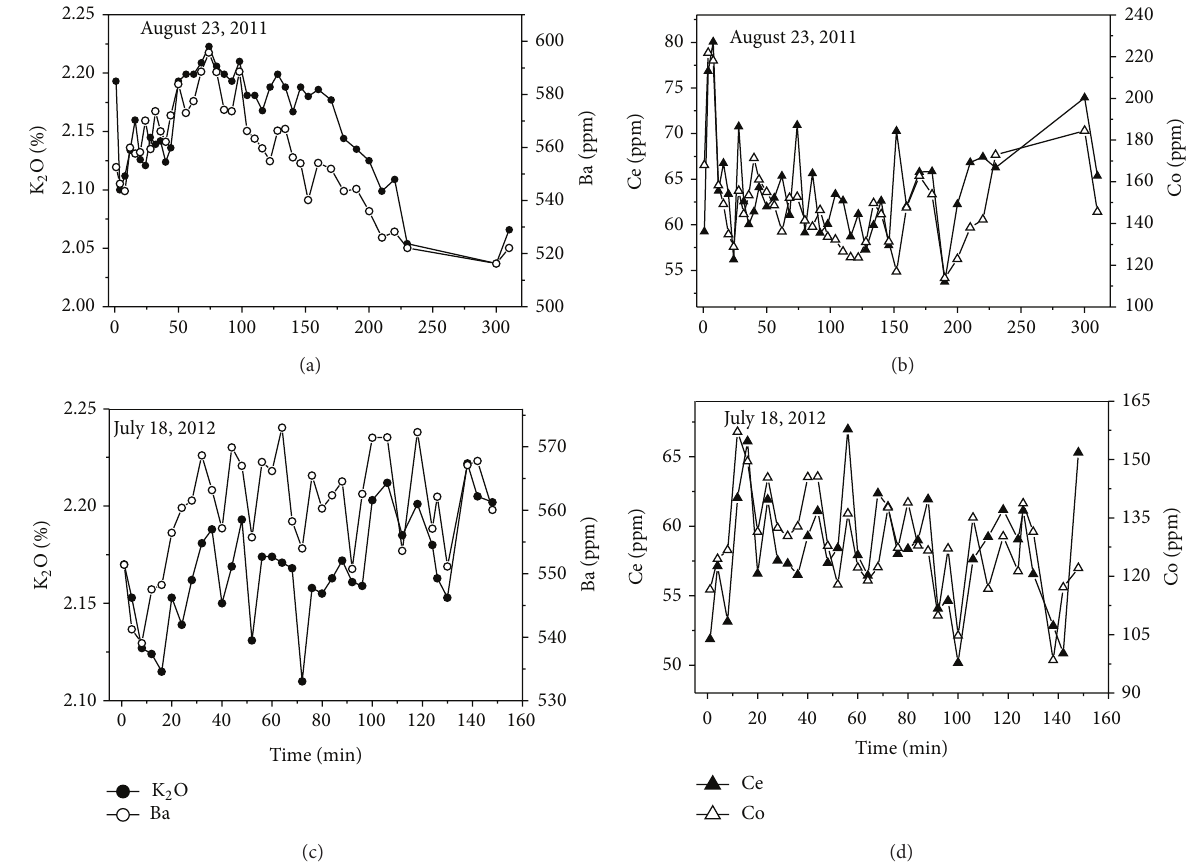
Figure 8: Temporal changes in elements K and Ba, Ce and Co during the two flood